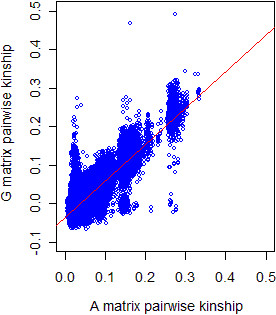
Plot of G vs. A pairwise kinship. Plot of genomic kinship (G) using the full set of LE markers (n = 9,579) against the pedigree-based kinship (A) for all pairwise combinations among all 945 L1 animals (n = 446,040). Trendline is given in red.